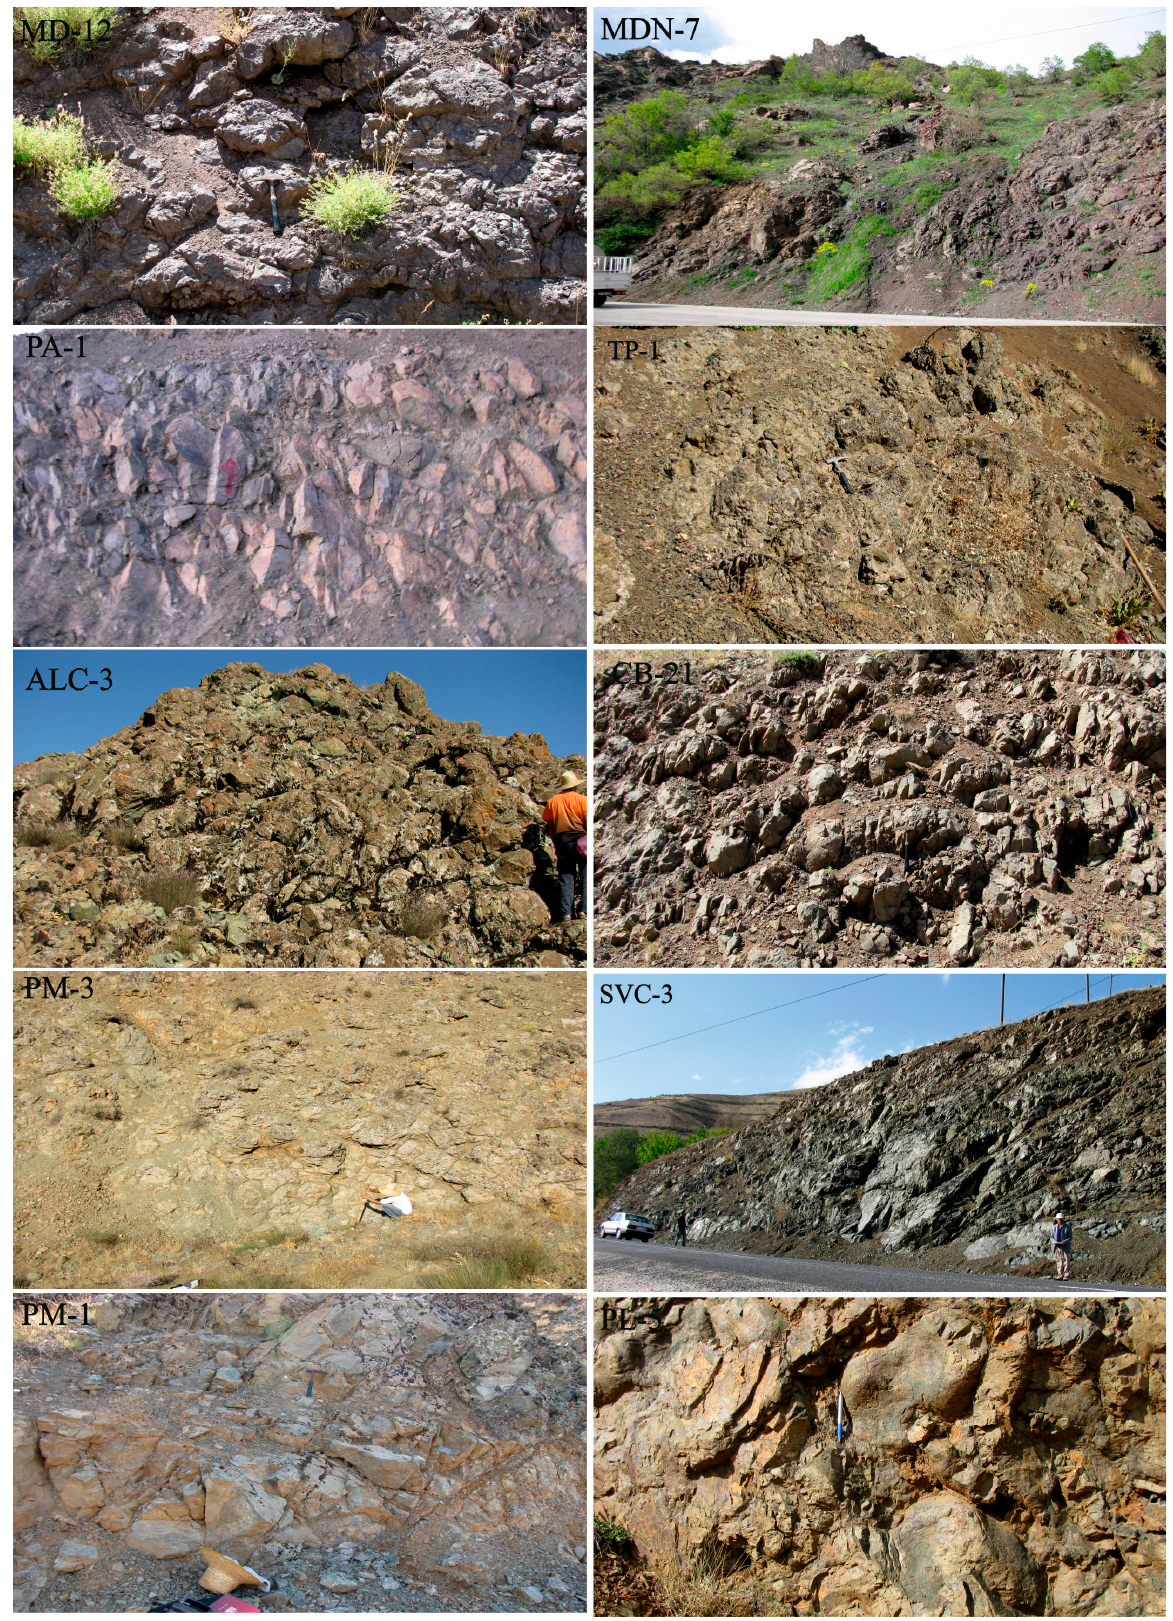
Figure 3. Field pictures of the Yüksekova Complex, showing the outcrops where the investigated samples were taken from the Elaz ı ğ area.